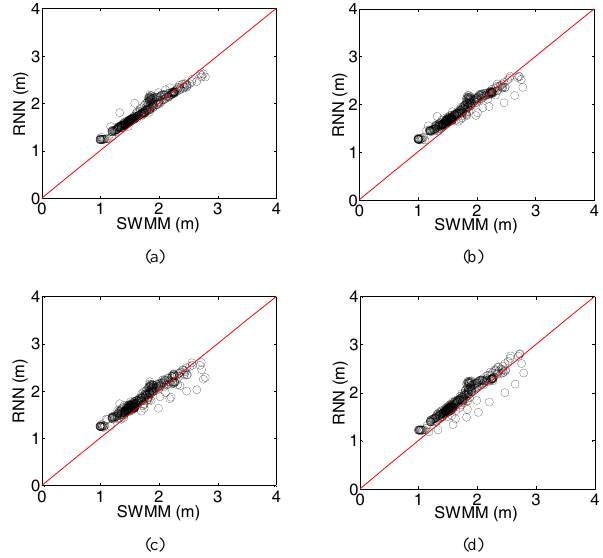
Figure 8 The scattering plots of the RNN outputs versus the SWMM estimations for 663 Fig. 8. The scattering plots of the RNN outputs versus the SWMM estimations for (a) 5-, (b) 10-, (c) 15-, and (d) 20-min-ahead pre- dictions in testing